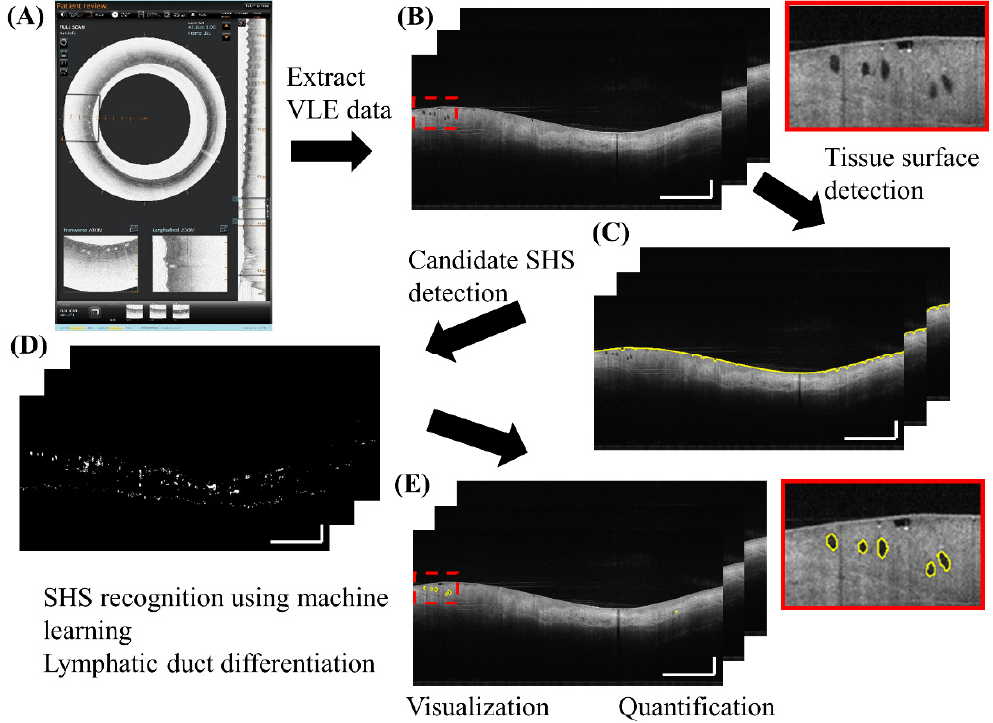
Figure 1. Fully automated algorithm for subsurface hyposcattering structure (SHS) detection and quantification. Inset: zoomed-in view. Scale bars: 1 mm.